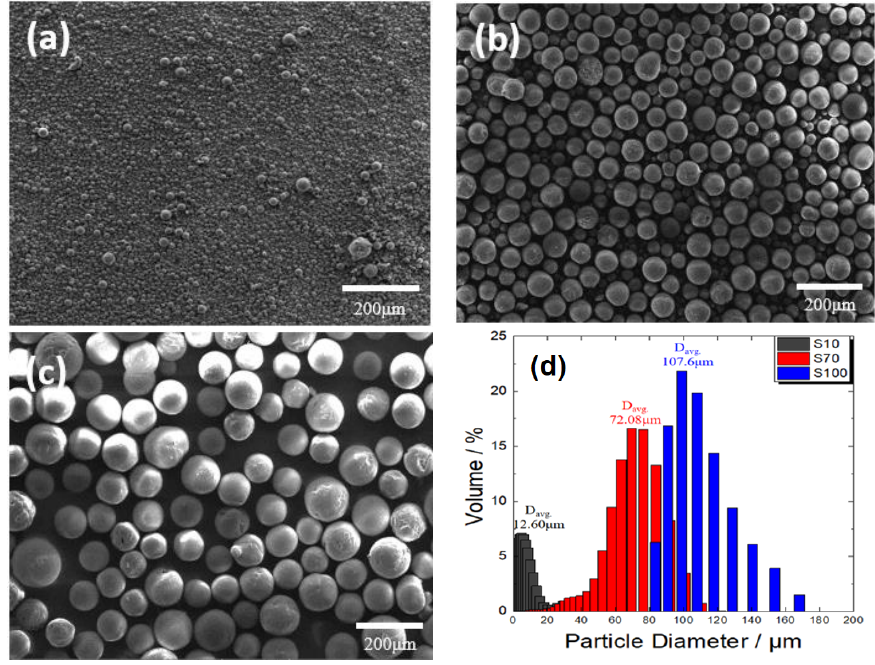
Figure 7. Scanning electron micrographs of spherical Al 2 O 3 powders with different average particle sizes. ( a ) 10 µ m, ( b ) 70 µ m, and ( c ) 100 µ m. ( d ) Particle size analysis